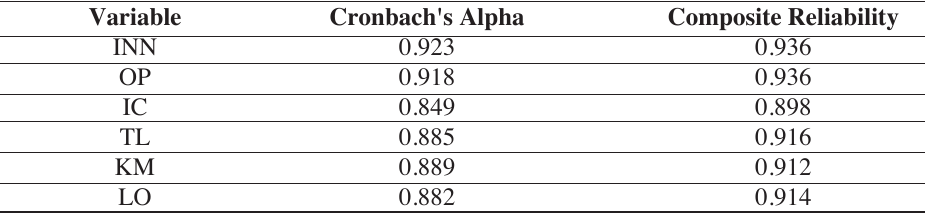
Table 3. Composite Reliability and Cronbach's